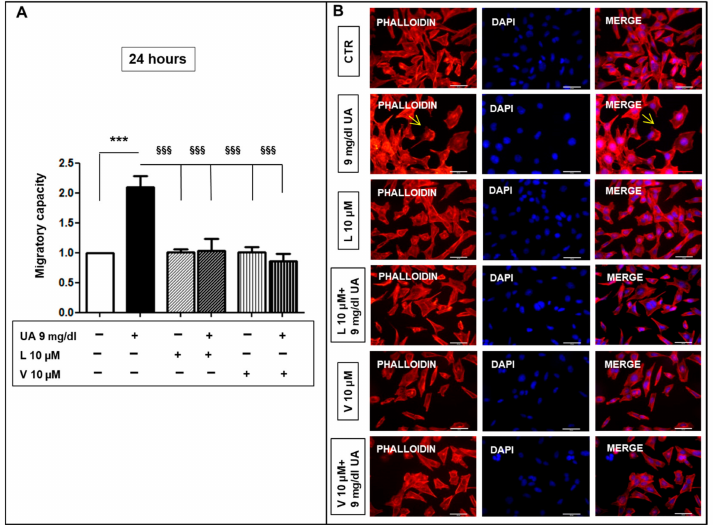
Figure 9. ARBs inhibited VSMC migratory capacity induced by UA. ( A ) Graph represents the inhibitory effects of L and V (both 10 µ M) on cell migration after 24 h exposition to 9 mg/dL UA. ( B ) This effect was confirmed by AlexaFluor 594-Phalloidin staining. As pointed by yellow arrows, only in UA-treated MOVAS, F-actin had a cortical distribution (magnification × 400, scale bar = 50 µ m). Results represent means ± SEM obtained from three/four independent experiments and are expressed as fold change to CTR. *** p < 0.0001 vs. CTR; §§§ p < 0.0001 vs. UA treated cells. ARBs = Angiotensin Receptor Blockers; VSMC = Vascular Smooth Muscle Cells; UA = Uric Acid; L = Losartan, V = Valsartan; CTR = control, untreated